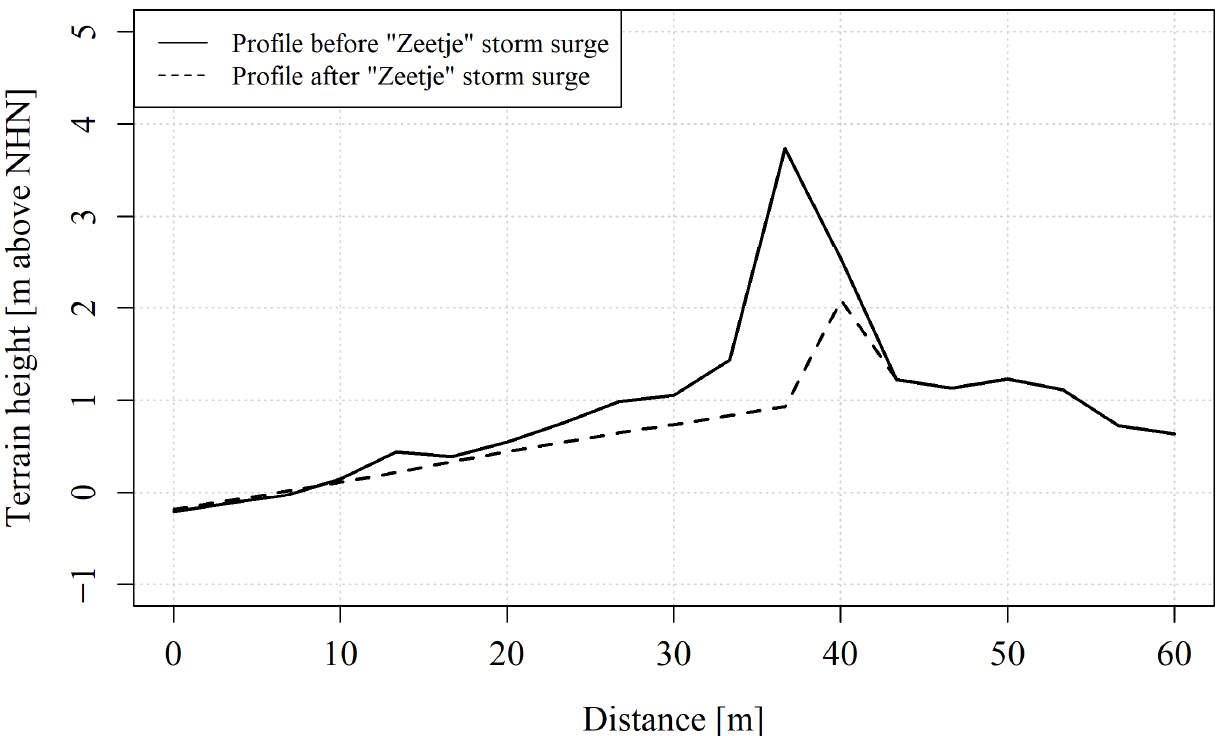
Figure 21. Representative cross-section of the Hütelmoor dune before and after “Zeetje”, derived from geodetic survey data (Data source: StALU MM).